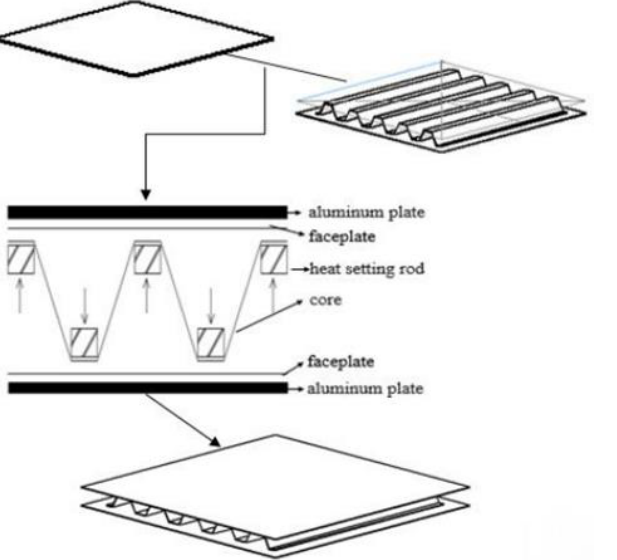
Figure 2. Schematic diagram of the molding process of thermoplastic corrugated sandwich panel.